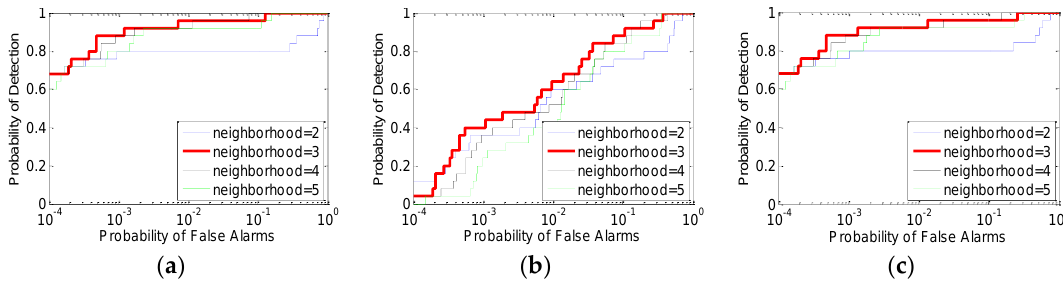
Figure 5. ROC curves obtained by using different sizes of neighborhoods: ( a ) CEM; ( b ) ACE; and ( c ) AMF.